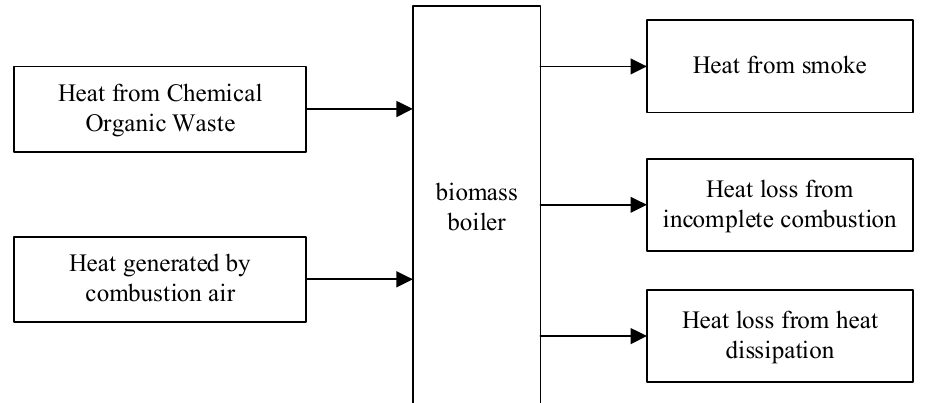
Figure 4. Heat input and output diagram of the biomass boiler.